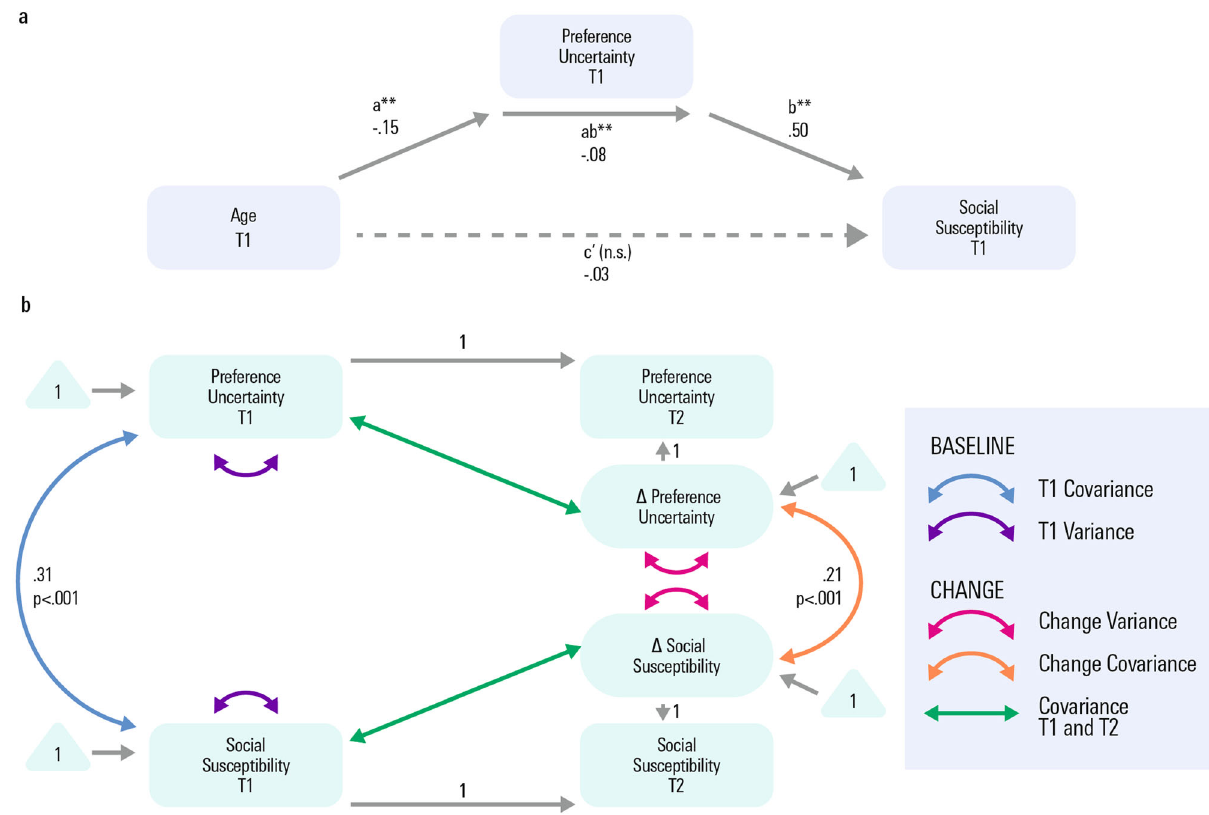
Fig. 5 Mediation analyses testing for a mediating role of preference uncertainty for the relationship of development with social susceptibility. a Mediation analysis for social susceptibility (i.e. preference shift measured in our delay discounting task) as predicted from age and mediated by preference uncertainty at T1. Age predicted preference uncertainty (path a). The mediator (preference uncertainty) predicted preference shift (path b, controlled for the age effect on preference uncertainty). Importantly, the mediation effect was signi fi cant (path ab). The direct path c ’ , namely the age effect on preference shift after accounting for the mediation, was not signi fi cant. The proportion of total variance accounted for by the mediation effect was signi fi cant. Thus, the age effect on social susceptibility at baseline was accounted for by preference uncertainty. b In line with our assumption that development of social susceptibility is accounted for by development of preference uncertainty, the bivariate latent change score model not only showed a signi fi cant covariation of preference uncertainty with social susceptibility at T1, but also signi fi cant covariation of the rate of longitudinal change in both domains. The full set of parameter estimates is included in Supplementary Information Table 2. n.s. not signi fi cant, T1 measurement time point 1, baseline assessment; T2 measurement time point 2, follow-up assessment after ~1 – 5 years.; ** denotes p < 0.001 Source data are provided as a Source Data fi